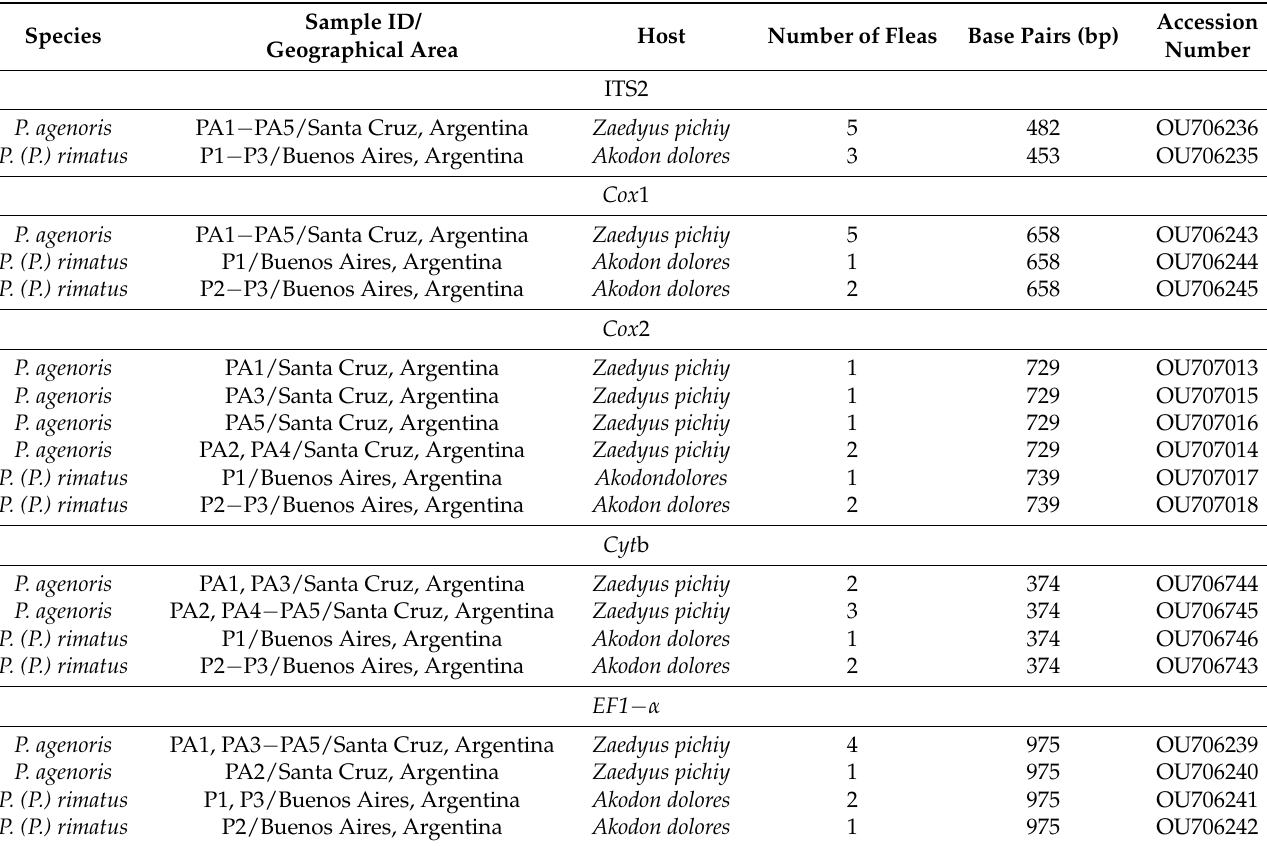
Table 1. GenBank accession numbers of ITS2, EF1 − α and partial cyt b, cox 1 and cox 2 gene sequences of individuals of Phthiropsylla agenoris and Polygenis rimatus obtained in this